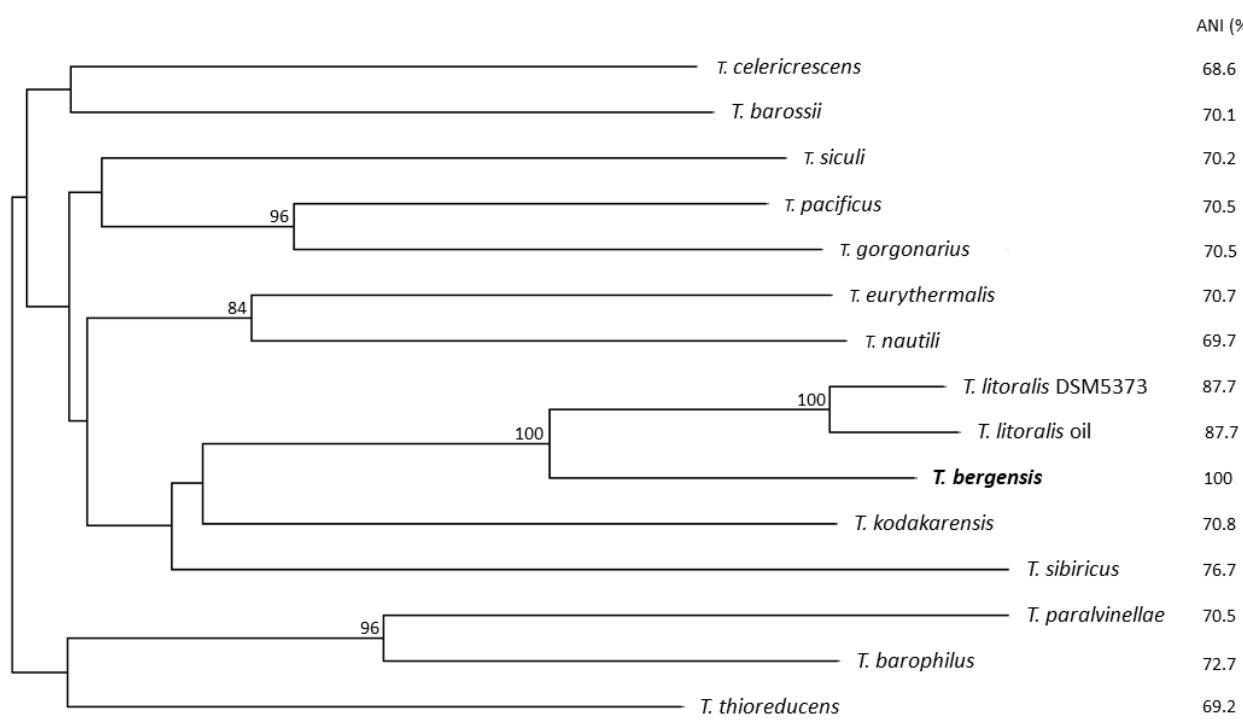
Figure 2. Phylogenomic tree of T. bergensis and other related Thermococcus type strains. The tree was inferred with FastME 2.1.6.1 [24] from genome blast distance phylogeny (GBDP) distances calculated from genome sequences using the TYGS server (https://tygs.dsmz.de, accessed on 2 March 2021) [22]. The branch lengths are scaled in terms of GBDP distance formula d5. The numbers